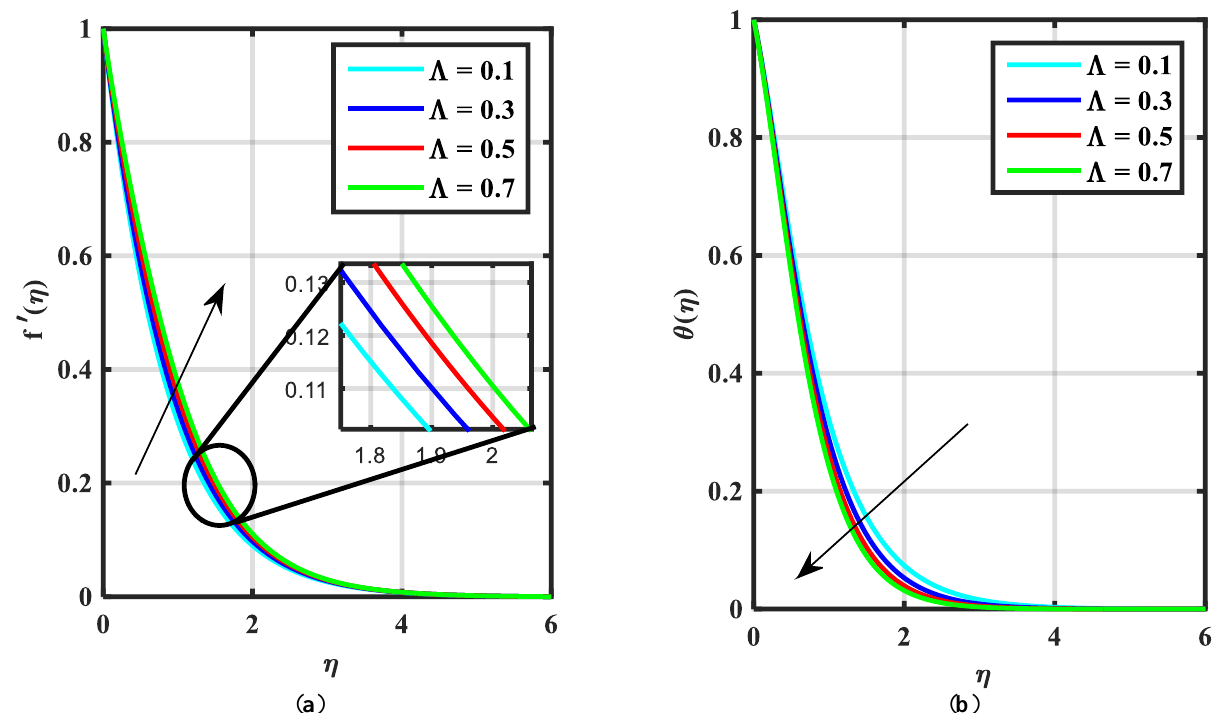
Figure 5. ( a , b ) Influence of 𝑓 ′ (𝜂), 𝜃(𝜂) over mixed convective parameter ⋀ .